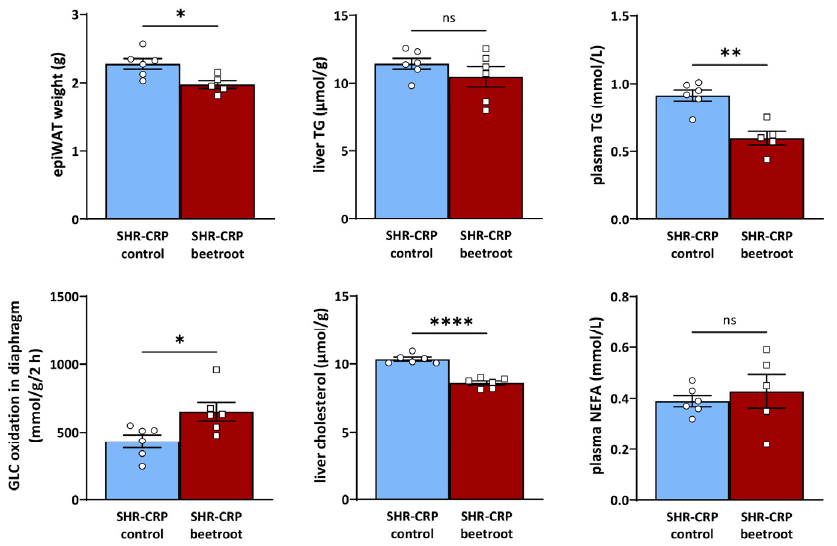
Figure 2. Parameters of lipid and glucose metabolism in SHR-CRP rats treated with beetroot and their untreated controls. *, **, and **** denote p < 0.05, p < 0.005, and p < 0.00005.